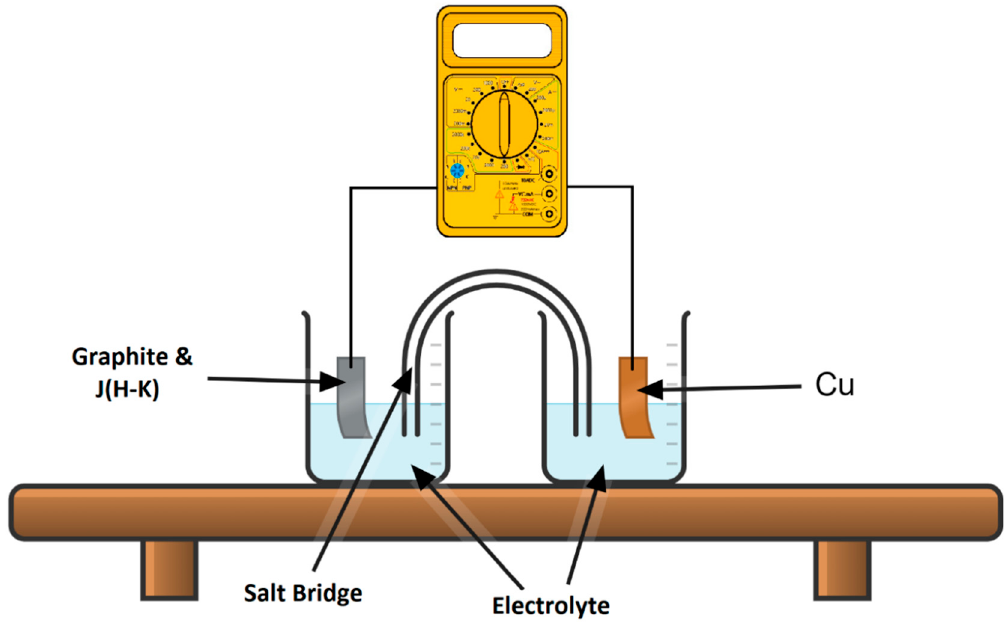
Figure 3. Experimental arrangement for electrical tests (Daniell’s Cell).